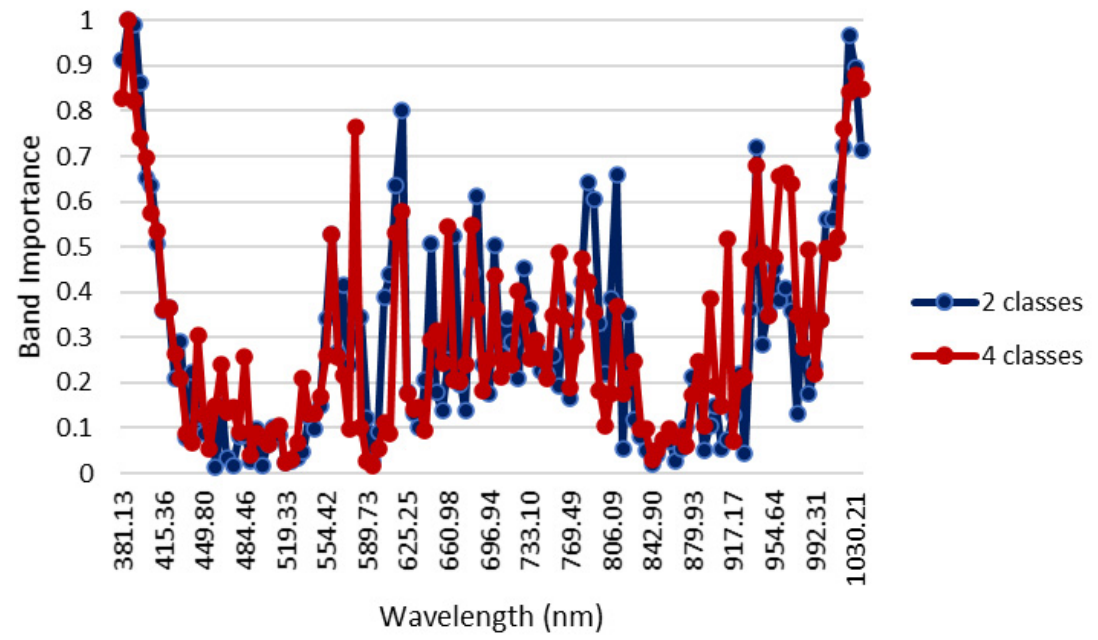
Figure 14. Band importance determined by XGBoost on the tubers differentiation phenological stage.